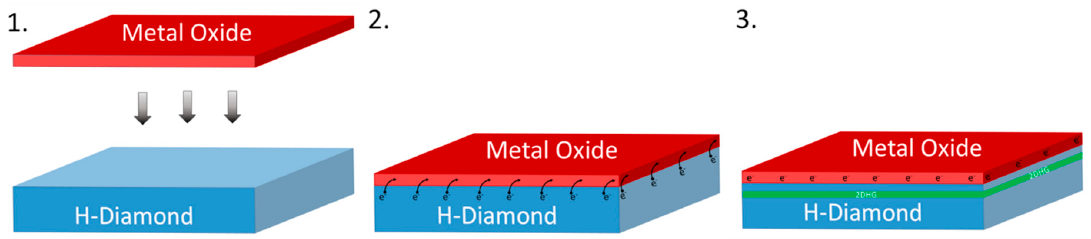
Figure 2. The creation of the two-dimensional sub-surface hole gas (2DHG) just below the diamond surface after interfaced with a suitable metal oxide.